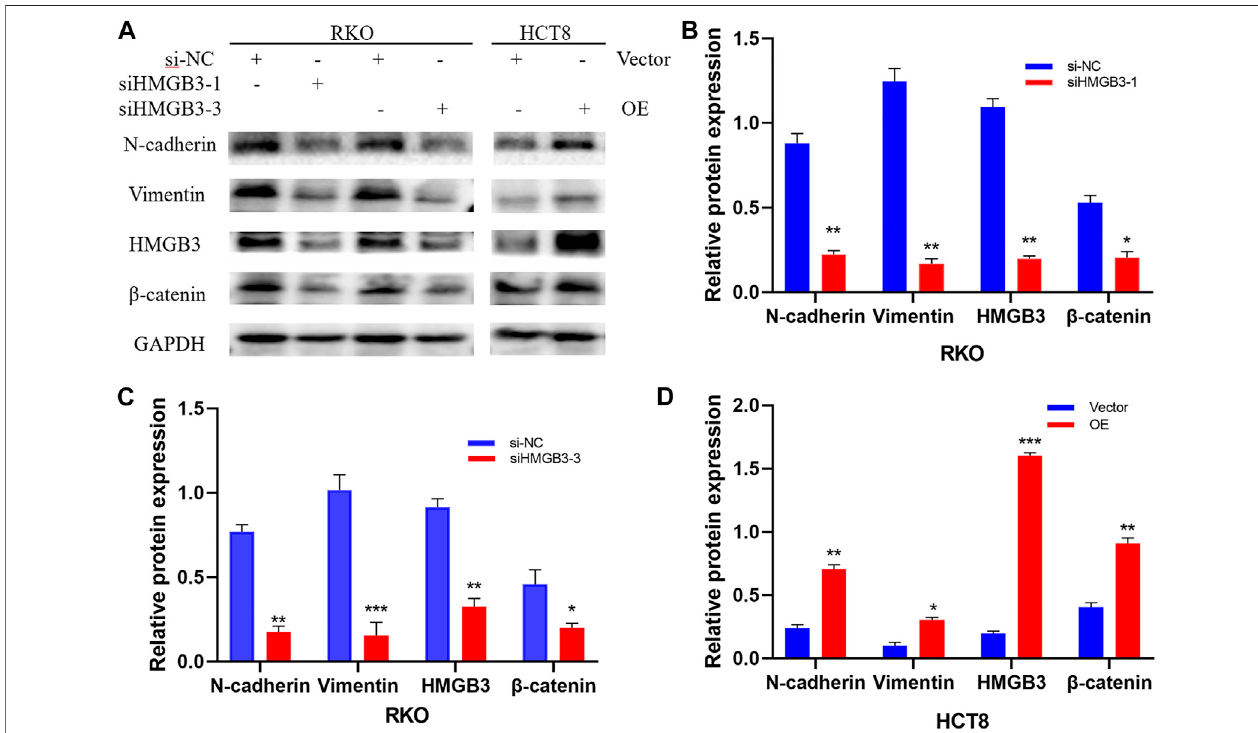
FIGURE 8 | Silencing and overexpression of HMGB3 in colorectal cancer cell lines and WB detection of cellular WNT/ β -catenin pathway proteins. There experiments were repeated for three times. (A) Western blot was performed to detect N-cadherin, Vimentin, HMGB3, β -catenin and GAPDH expression after Silencing and overexpression of HMGB3. (B) N-cadherin, Vimentin, HMGB3 and β -catenin expression after siHMGB3-1 Silencing in RKO cell. (C) N-cadherin, Vimentin, HMGB3 and β -catenin expression after siHMGB3-3 Silencing in RKO cell. (D) N-cadherin, Vimentin, HMGB3 and β -catenin expression after overexpression in HCT8 cell. GAPDH served as the loading